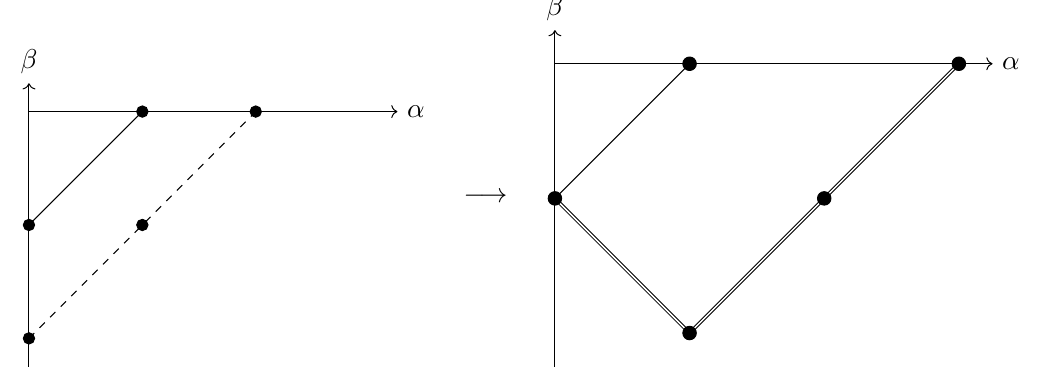
Figure 3 . Another typical configuration of the Newton diagram generated by a G 4 -flux containing two different d ’s. In the left figure, we superpose all Newton diagrams of ˜ F d, ˜ n corresponds to ˜ F ˜ of the highest ˜ d , and the dashed line corresponds a possible lower d . On the d, ˜ n ˜ d right we show the end result. The double lines correspond to the Newton polygon of ˜ F . In the situation shown in this figure, the segment of the Newton polygon with positive slope will generate an axion backreaction behavior similar to figure 2, while the segment with negative slope will